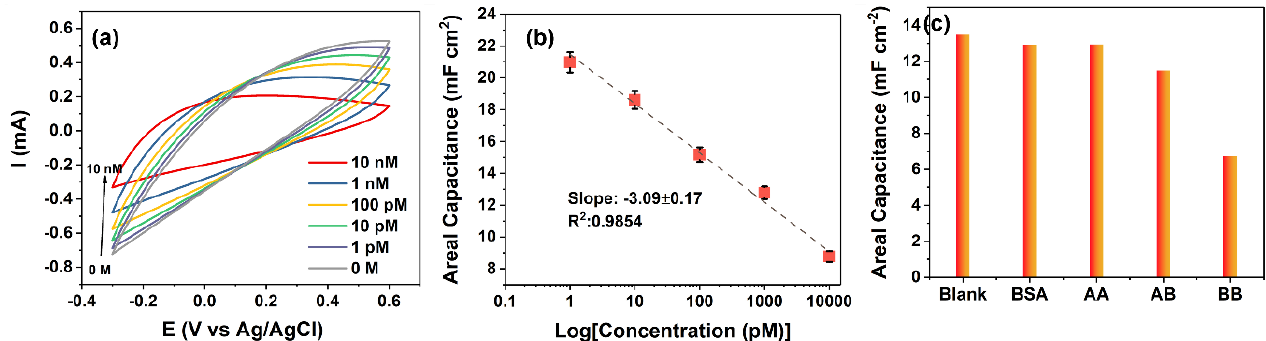
Figure 6. ( a ) CV curves of the C-MEMS/rGO/Apt electrode’s response to PDGF-BB ranging from 0–10 nM. ( b ) Calibration curve for calculated areal capacitances from CV curves with n = 3. ( c ) Areal capacitances calculated from CV curves measured in response of C-MEMS/rGO/Apt elec- trodes to 4 µg mL −1 BSA. 50 nM PDGF-AA, 50 nM PDGF-AB, and 500 pM PDGF-BB.